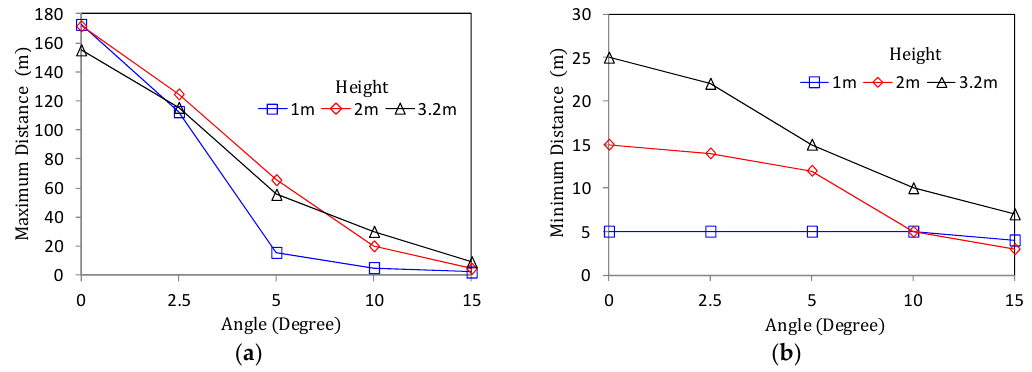
Figure 9. Detection distance of RWM according to radar angle: ( a ) Maximum detection distance; ( b ) minimum detection distance.